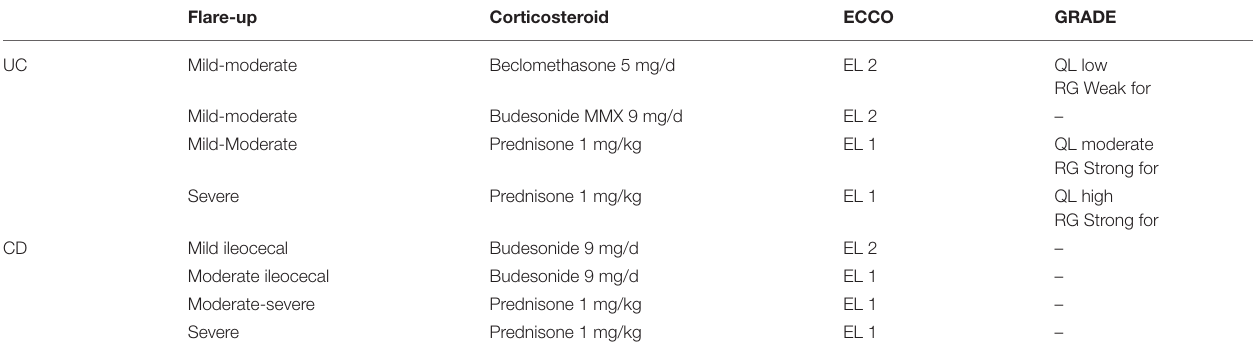
QL, Quality of evidence; EL, Evidence level; RG, Recommendation Grade.